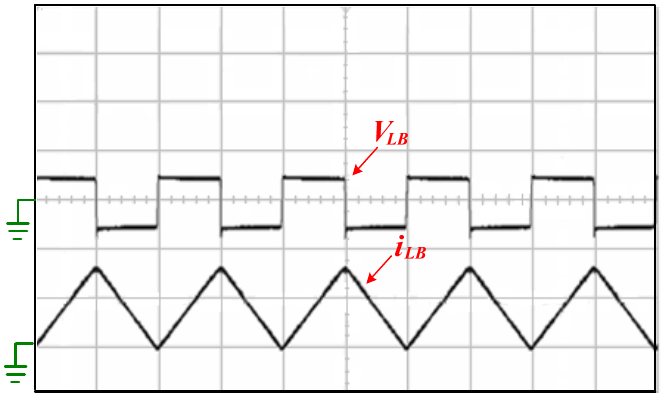
Figure 21. Measured voltage and current waveforms of inductor L i : 5 A/div time: 10 µs/div. For non-dispassive voltage equalization circuit. LB